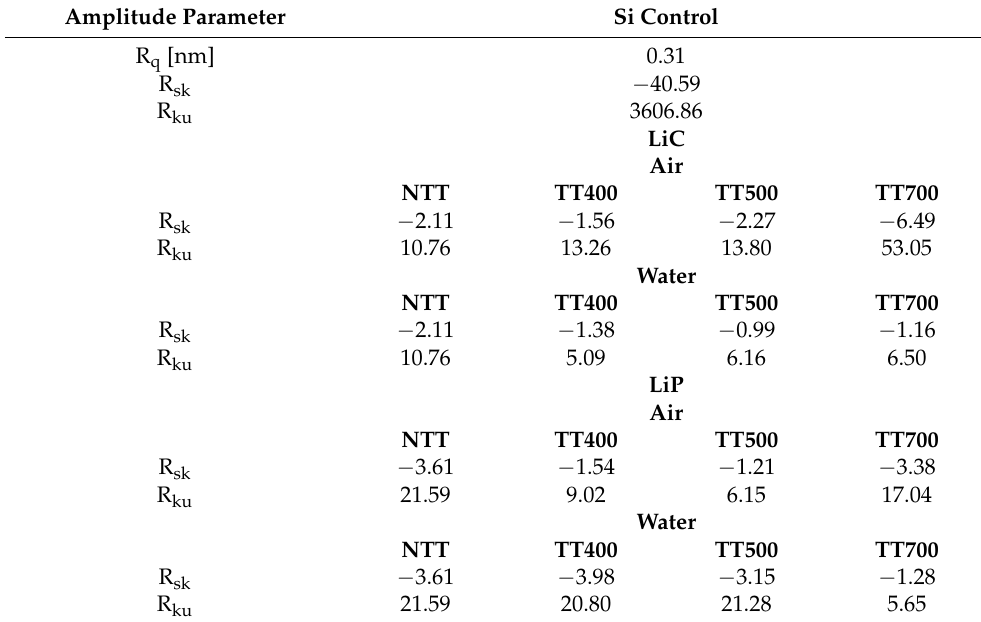
Table 1. Surface amplitude parameters (R q , R sk and R ku ) for a (20 × 20 µ m 2 ) scanned surface area of control Si, NTT LiC and LiP coatings and of those subjected to post-deposition thermal treatments (at different temperatures), in air and water-vapor ambient. Amplitude